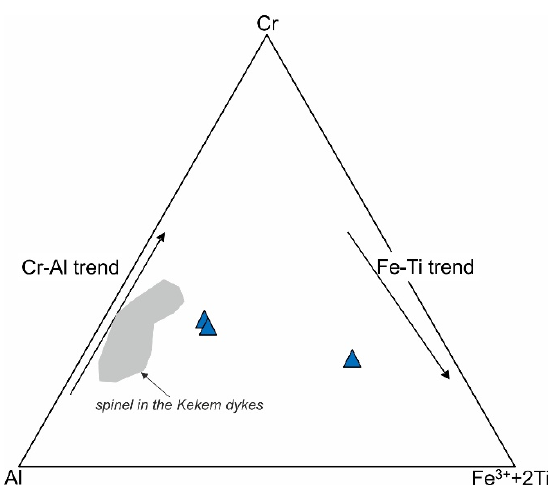
Figure 7. Chemical variations of chromium-rich spinels in the Njimom dykes. The field of spinels of the Kekem dykes is also shown [5].